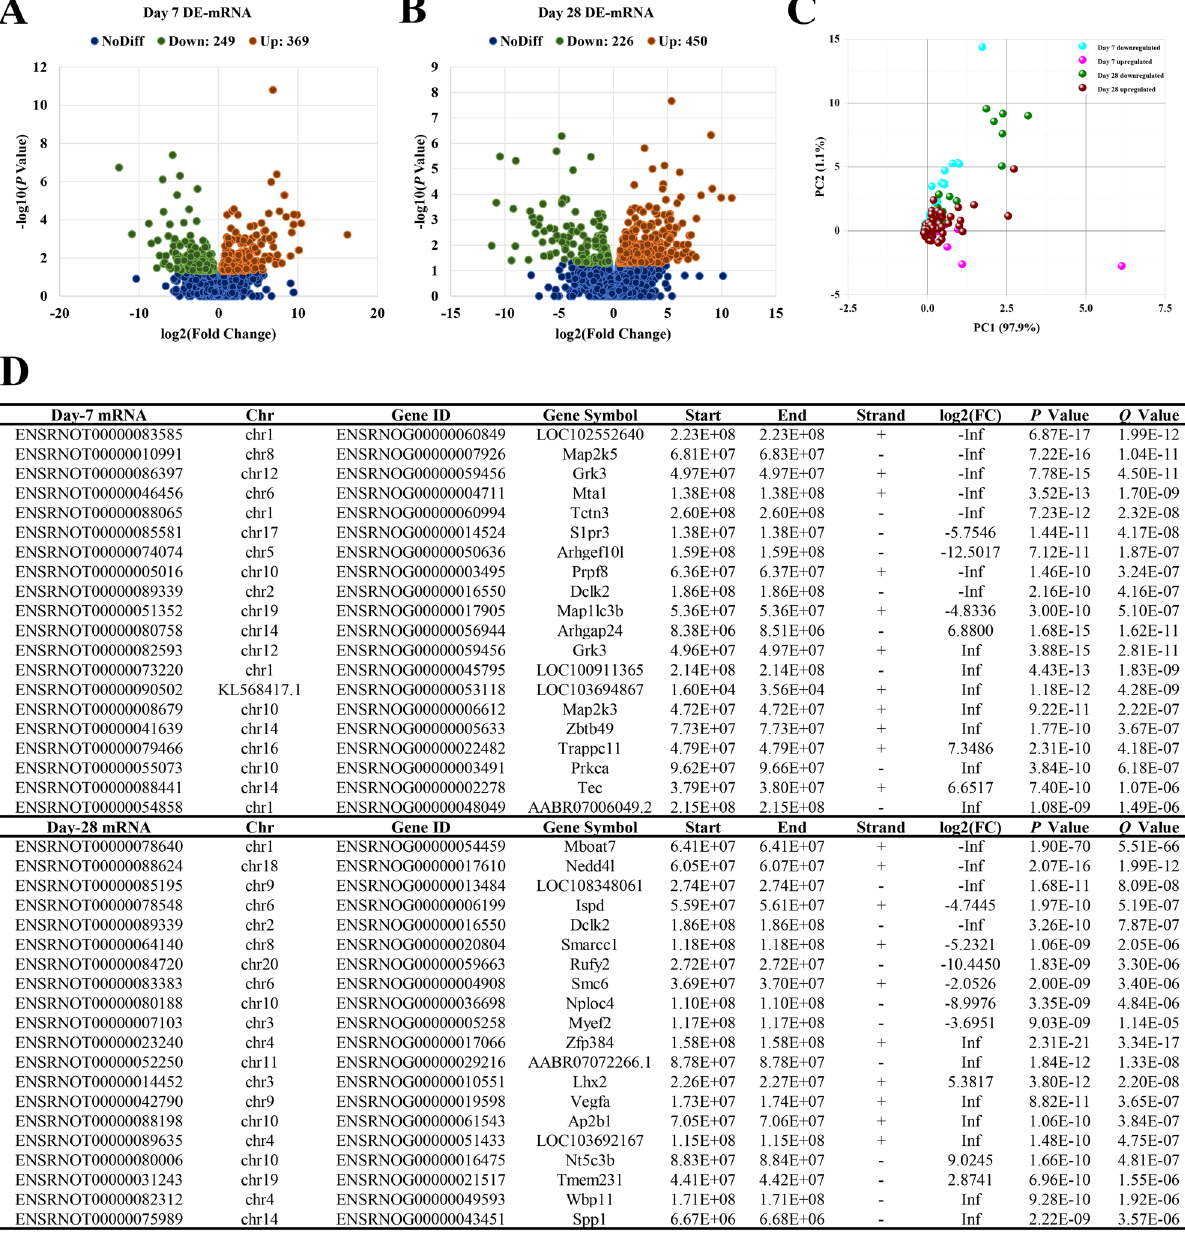
Figure 2. Differences in the mRNA expression profile between Sham and ICH groups. ( A ) Volcano plot showed differential expression of mRNAs between Sham and ICH groups on the 7th day. ( B ) Volcano plot showed differential expression of mRNAs between Sham and ICH groups on the 28th day. ( C ) PCA plot revealed the discrimination between day-7 and day-28 samples. ( D ) Top 10 differentially downregulated and top 10 differentially upregulated mRNAs, in ICH samples, on days 7 and 28, respectively. The horizontal line in the volcano map represented the fold (log 2 scaled) down or up changes; the vertical line represented a corrected P value of 0.05 (-log 10 scaled); green spots indicated the differentially down-expressed RNAs with statistical significance; red spots indicated the differentially up-expressed RNAs with statistical significance; blue spots indicated RNAs with no statistically significant expression. The variances explained by the principal components chosen were shown as PC1 and rat brain tissues, 249 were found to be statistically downregulated and 369 were statistically upregulated in ICH compared with Sham on day 7 (Fig. 2A), and 226 statistically downregulated and 450 statistically upregulated mRNAs were found in ICH compared with Sham on day 28 (Fig. 2B). Moreover, the variance (99.0%) explained by the principal components revealed a discrimination between day-7 and day-28 samples (Fig. 2C). The detail of these differentially expressed mRNAs was summarized in Supplementary Table S4. The top 10 most significantly up- and downregulated mRNAs in each time point were shown in Fig. 2D. Among the 918 miRNAs detected,